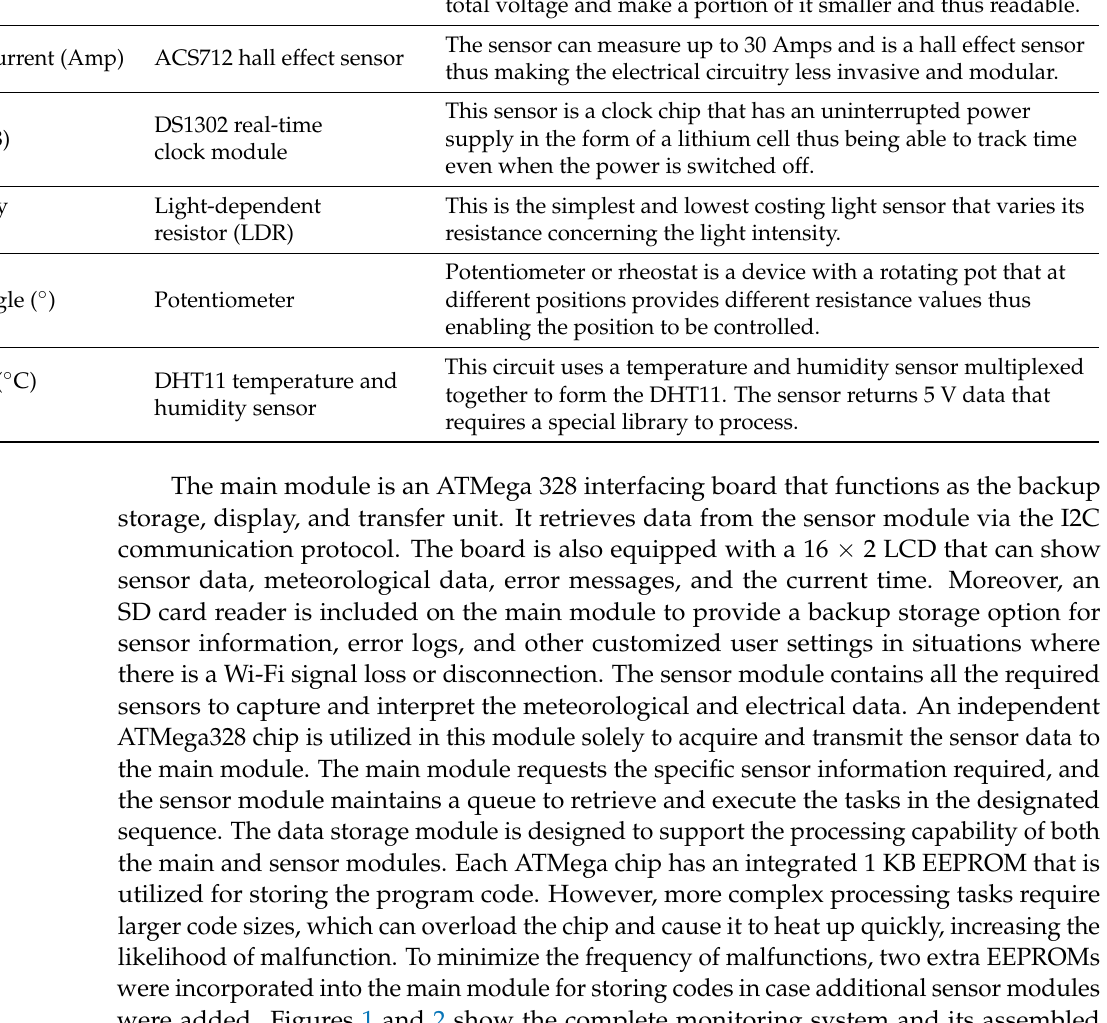
Figure 2. Final assembled miniature tracking system.